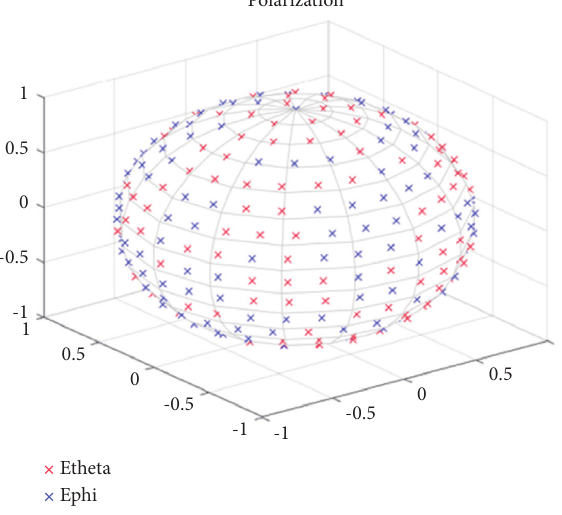
Figure 9: Sampling strategy described in case 3.